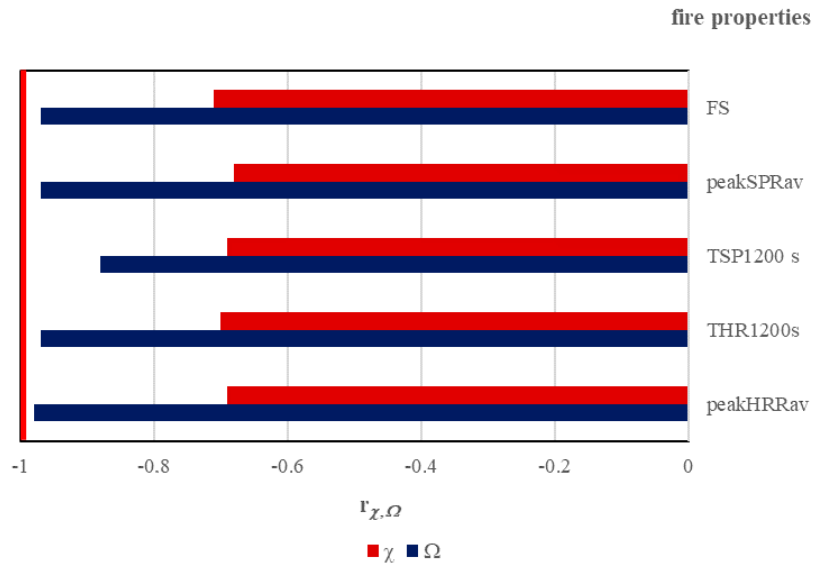
Figure 6. Comparison of r values for cable parameters χ and Ω .